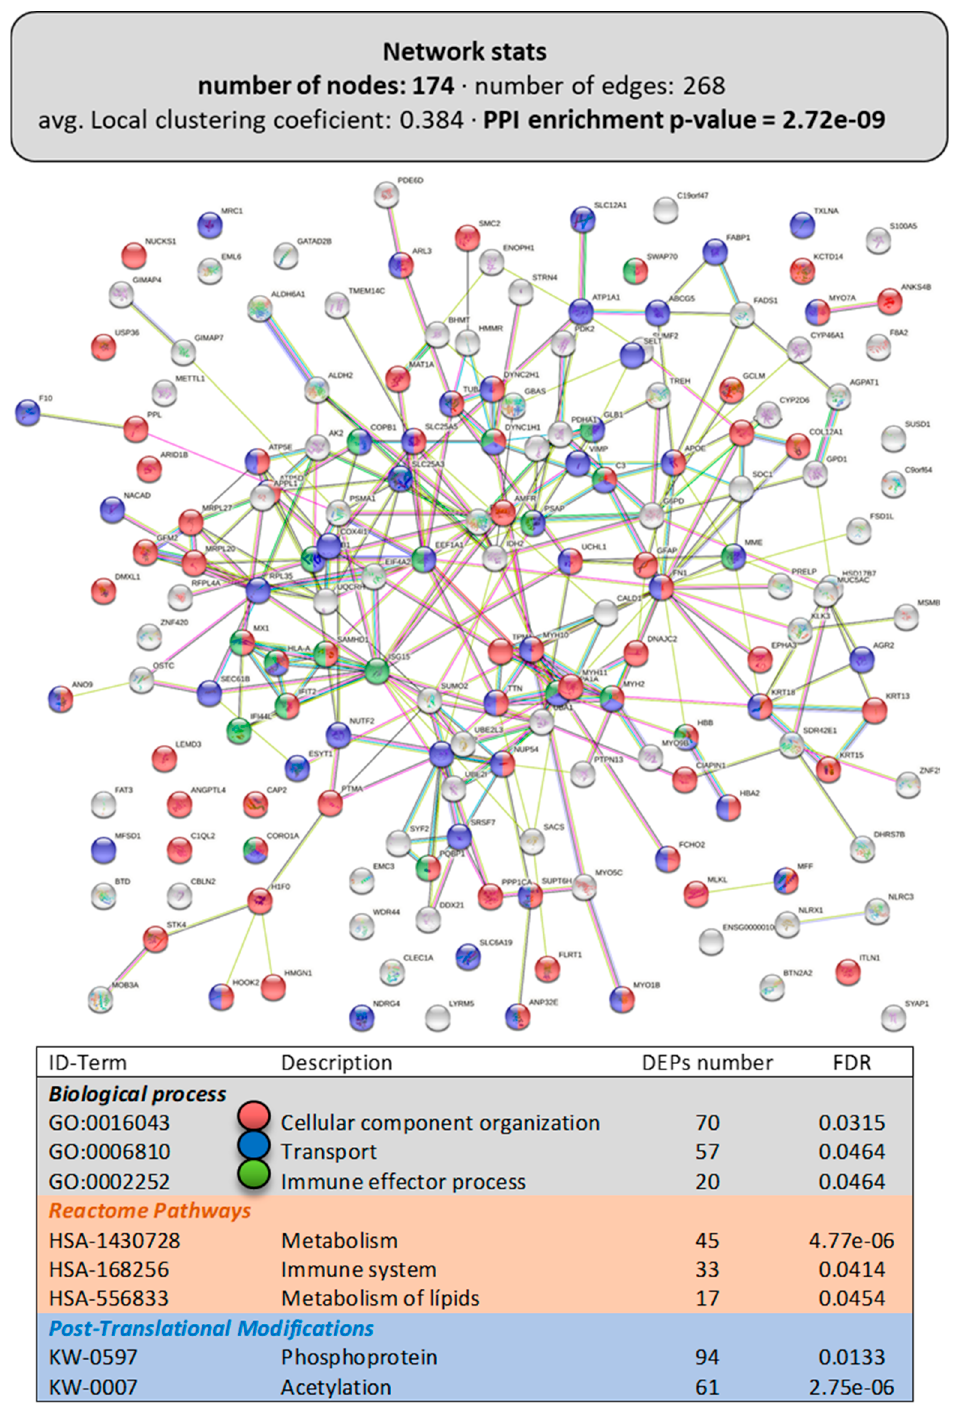
Figure 2. Functional enrichments in the interactome of the intestine of LPL-fed salmon. Each node represents one differentially expressed protein (DEP) obtained from mucus shotgun proteomics (details in Supplementary File S1). Details on the functional network statistics (network stats) are indicated ( top ). The selected relevant biological processes ( bottom ) are presented with the corresponding colors in each node. The main Reactome pathways and post-translational modifications (PTMs), clustered significantly by the false discovery rate (FDR) value, are also summarized ( bottom table ).